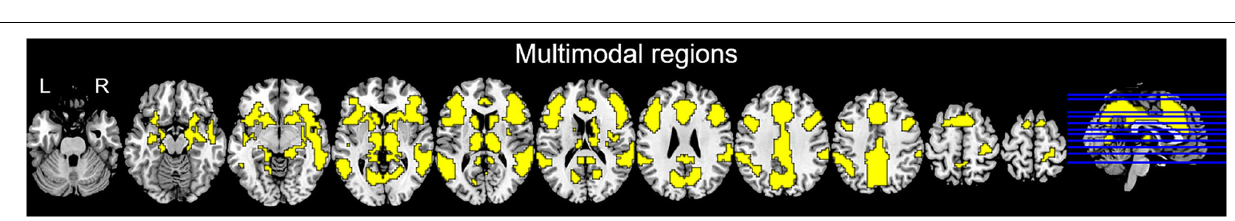
FIGURE 2 | Brain regions activated by each type of sensory stimulation, as revealed by General Linear Model (GLM) ( P < 0.0001, FDR-corrected).